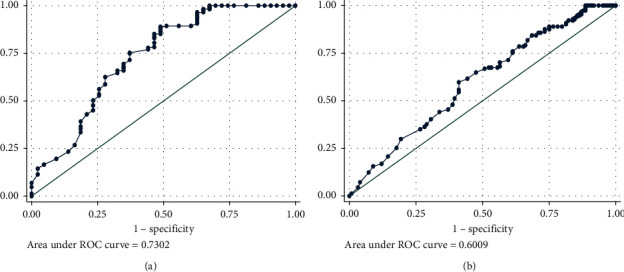
The area under the ROC curve of FeNO in detecting (a) GINA-defined uncontrolled asthma and (b) GINA-defined well-controlled asthma.